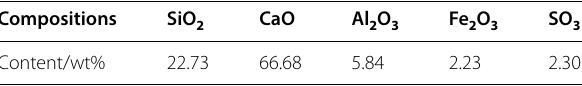
Table 2 Chemical properties of cement.